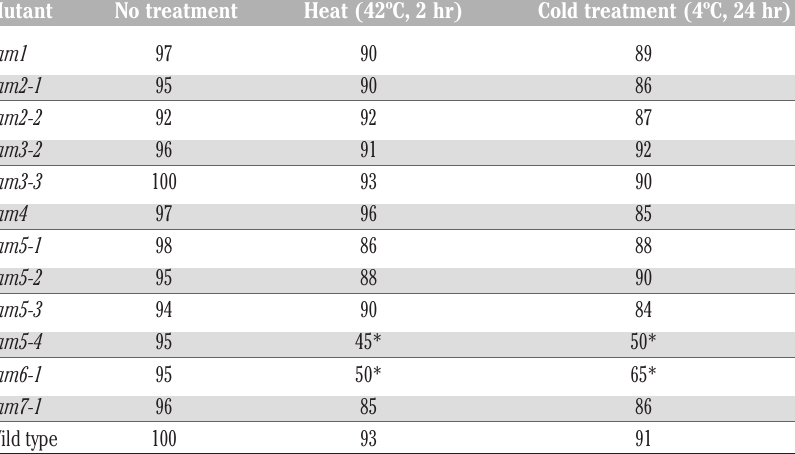
Table 2. Germination % for all cam mutants under heat (42°C, 2 hours) and cold (4ºC, 24 hours) treatments in A.thaliana. Two sets with three replicates of fifty seeds each of the wild type and cam mutants were surface sterilized and exposed to 4ºC for 24 hours and 42ºC for 2 hours, separately. Treated seeds were plated on MS salt-agar medium and allowed to germinate at 25ºC under continuous light for seven days. The percent of ger- minating seeds were scored. Mutants with (*) represent the significant seed sensitivity